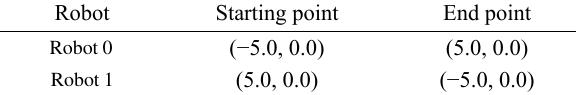
Fig. 7 Single channel scenario built with Gazebo. Table 2 Start point and end point coordinates of the